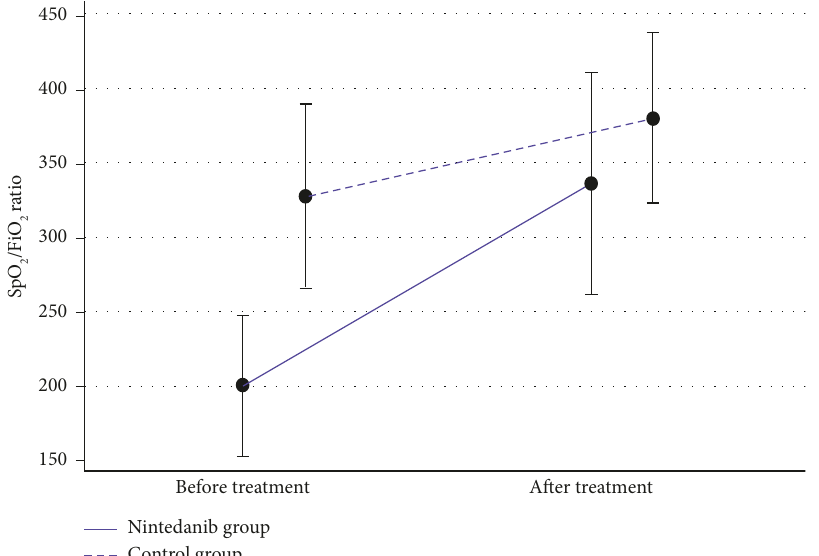
Figure 2: Oxygen saturation to fraction of inspired oxygen (SpO